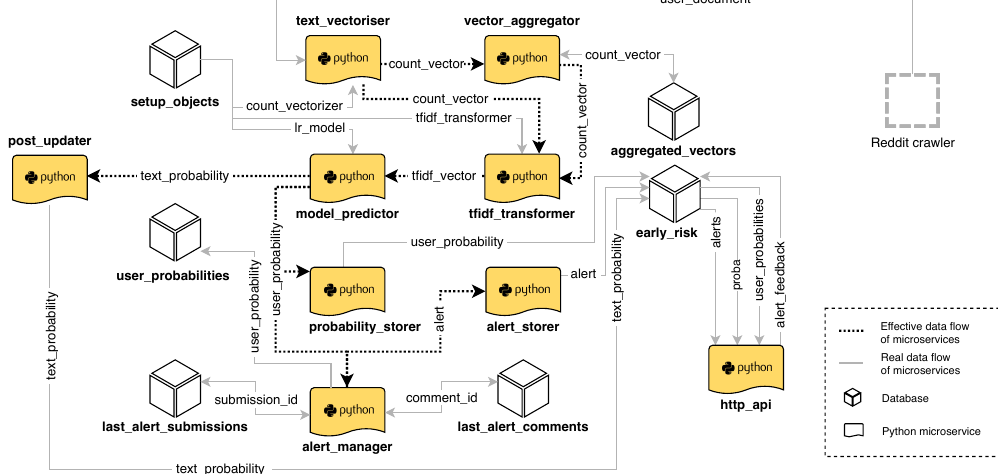
Figure 4. Architecture that supports early detection of signs of